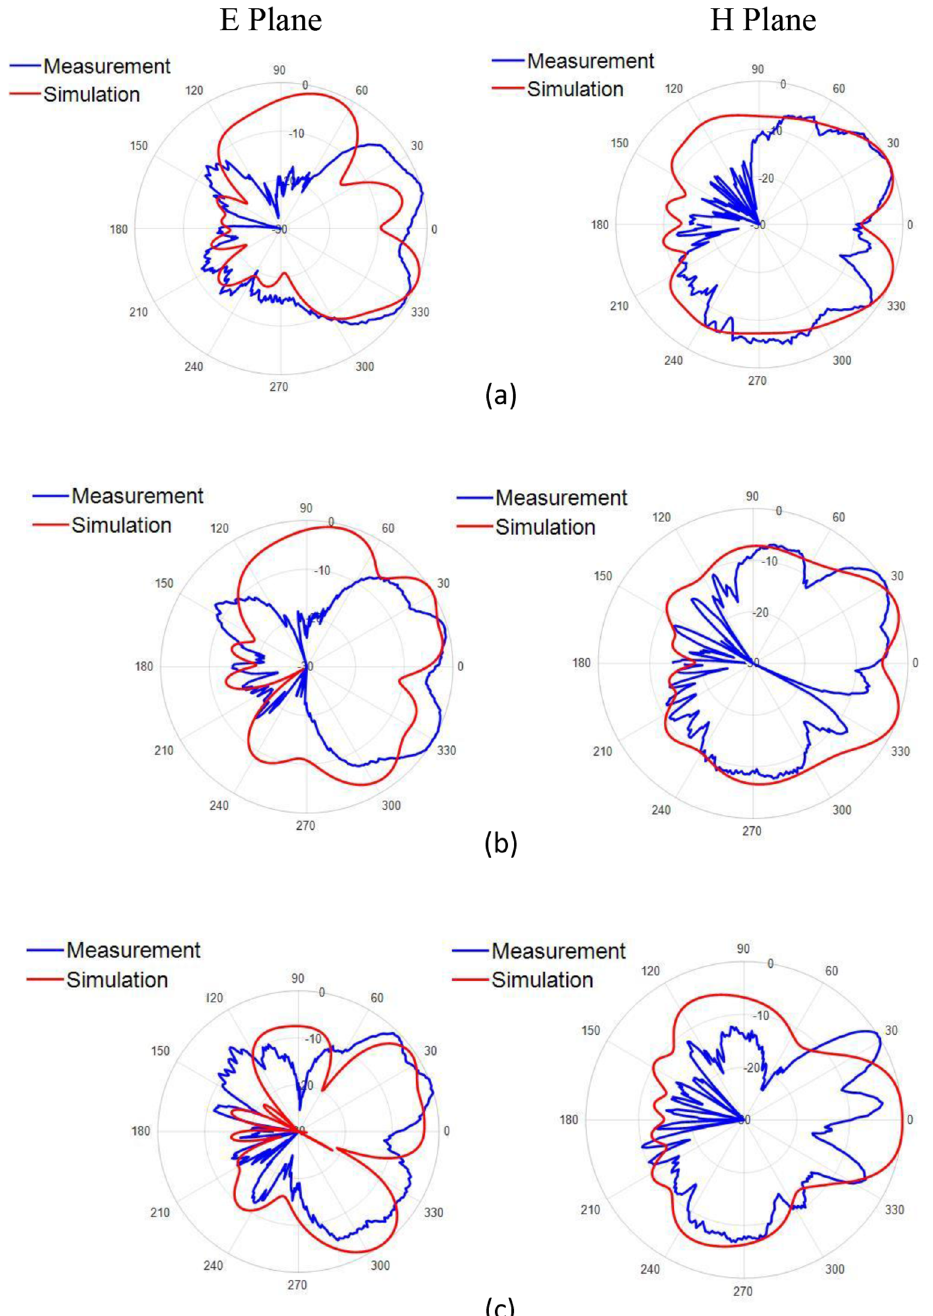
Fig. 6. Normalized measured and simulated radiation pattern of the metaferrite based U-slot patch antenna with E- and H-plane at the frequencies of (a) 8.65 GHz, (b) 8.8 GHz and (c) 9